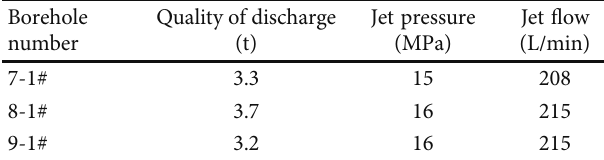
Table 2: Test parameters in the fi rst punching area.